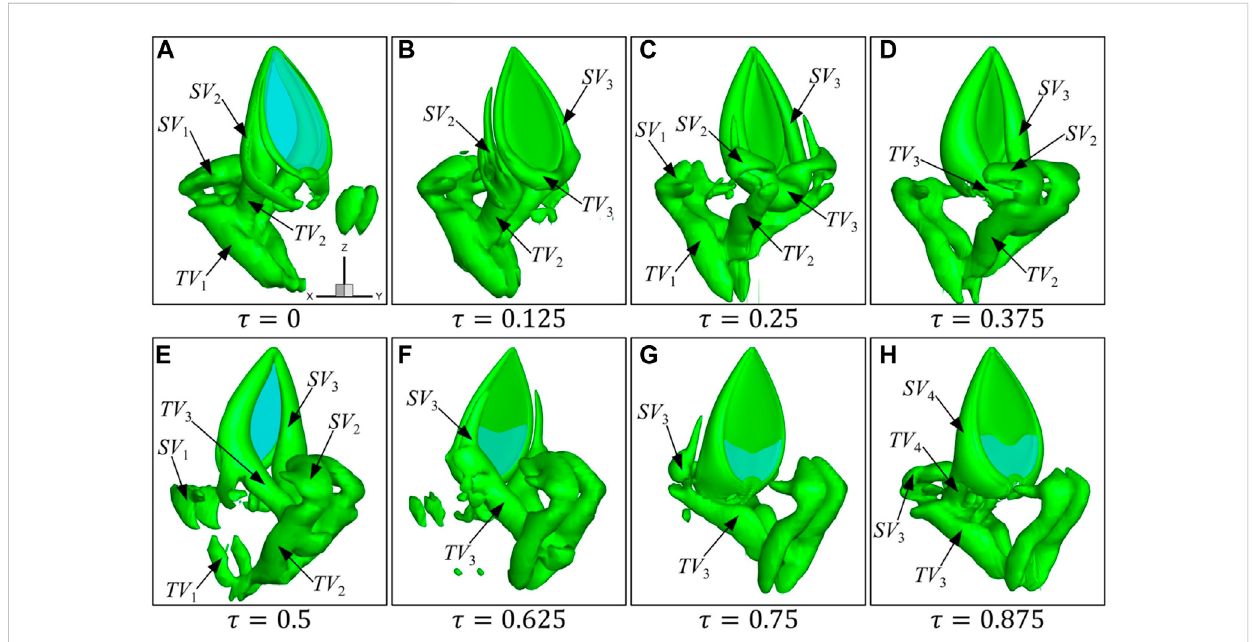
FIGURE 5 Formation and evolution of vortices at eight typical instants (A – H) during one fl apping cycle for a single wing at Φ (cid:1) 40 ° . In all snapshots, the iso- surface of the Q criterion with Q (cid:1) 2 is shown.